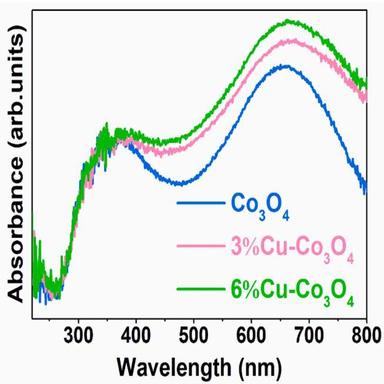
UV–Vis DRS spectra of undoped Co3O4, 3%Cu–Co3O4, and 6%Cu–Co3O4.